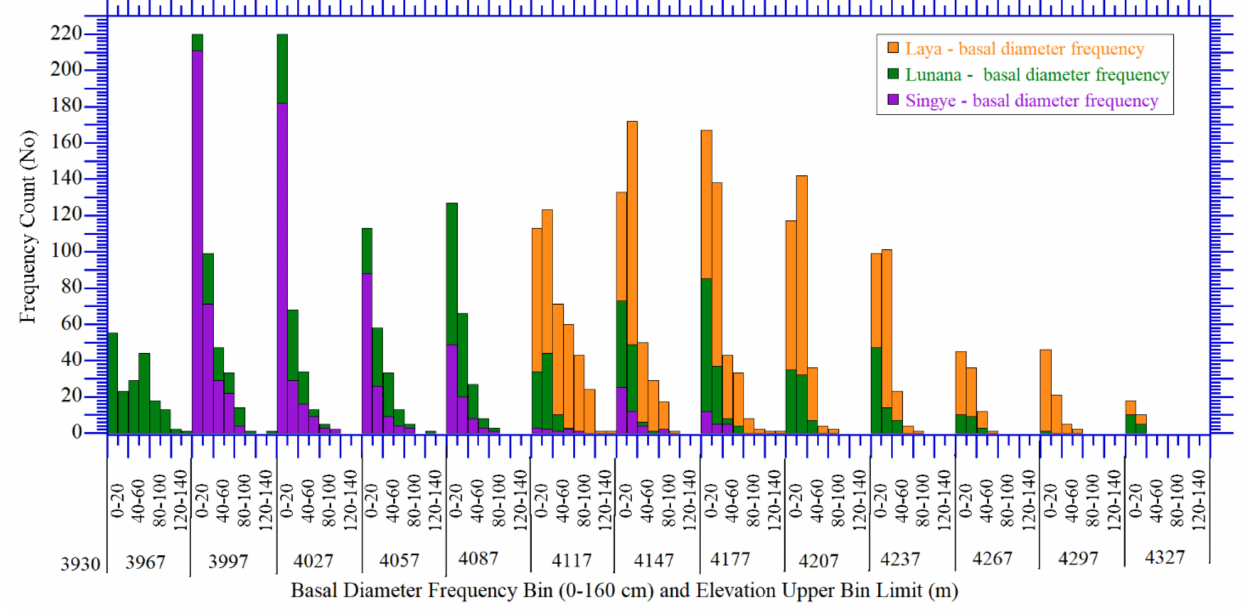
Figure 4. Frequency distribution against basal diameter classes and elevation classes in three treeline ecotones. Treeline ecotones of all ten transect bands in Lunana (green stake column), Laya (golden stake column) and Singye (purple stake column) portray their frequency distribution (Unimodal, reverse Jshaped) in their respective classes. Figure generated using Kaleida Graph